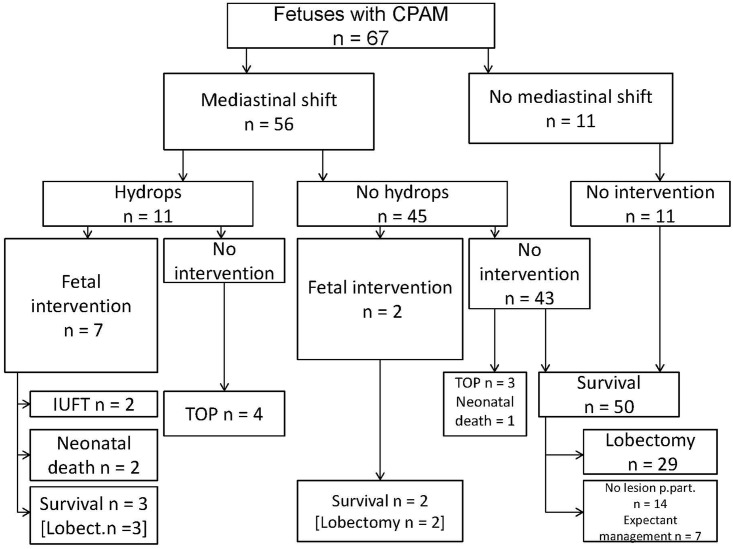
Flow chart showing management and pregnancy outcome of 67 fetuses with prenatally diagnosed CPAM.